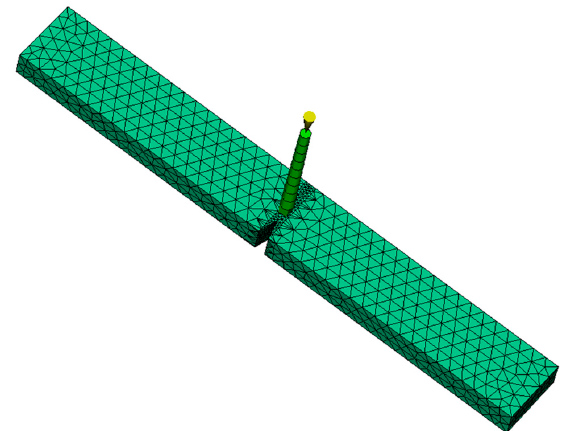
Figure 3. Finite element model of the specimen.